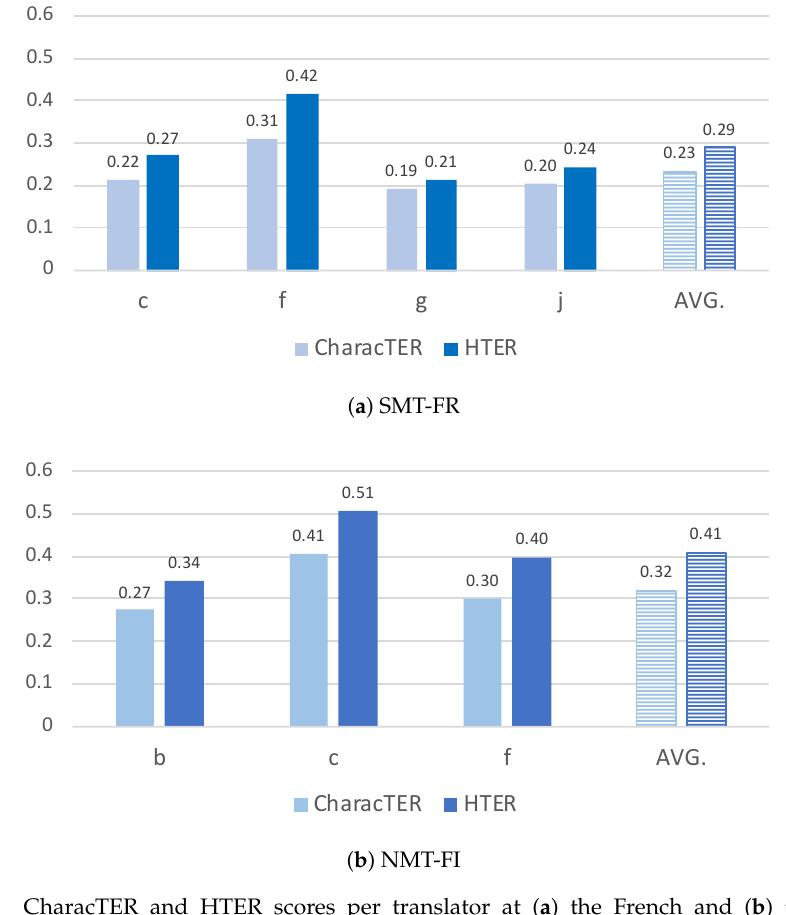
Figure 7. CharacTER and HTER scores per translator at ( a ) the French and ( b ) the Finnish language